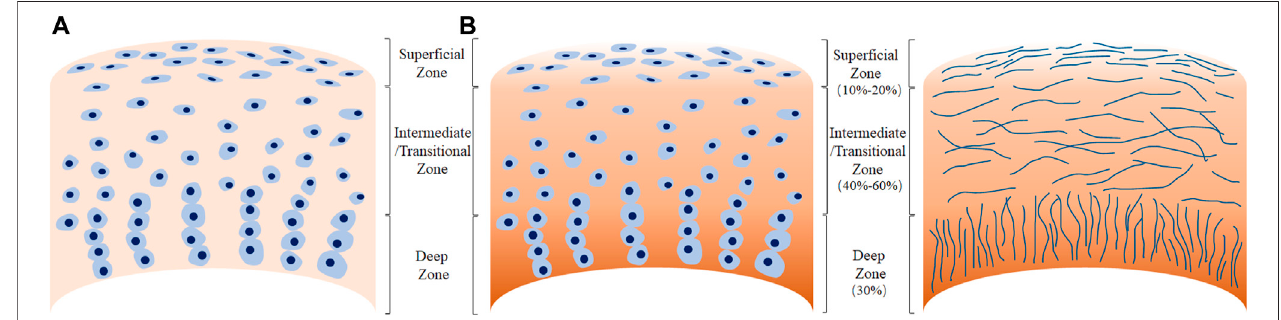
FIGURE 1 | Morphology of human adult articular cartilage. (A) , chondrocytes organization in the different tissue zones. (B) , arrangement of collagen fi bers.